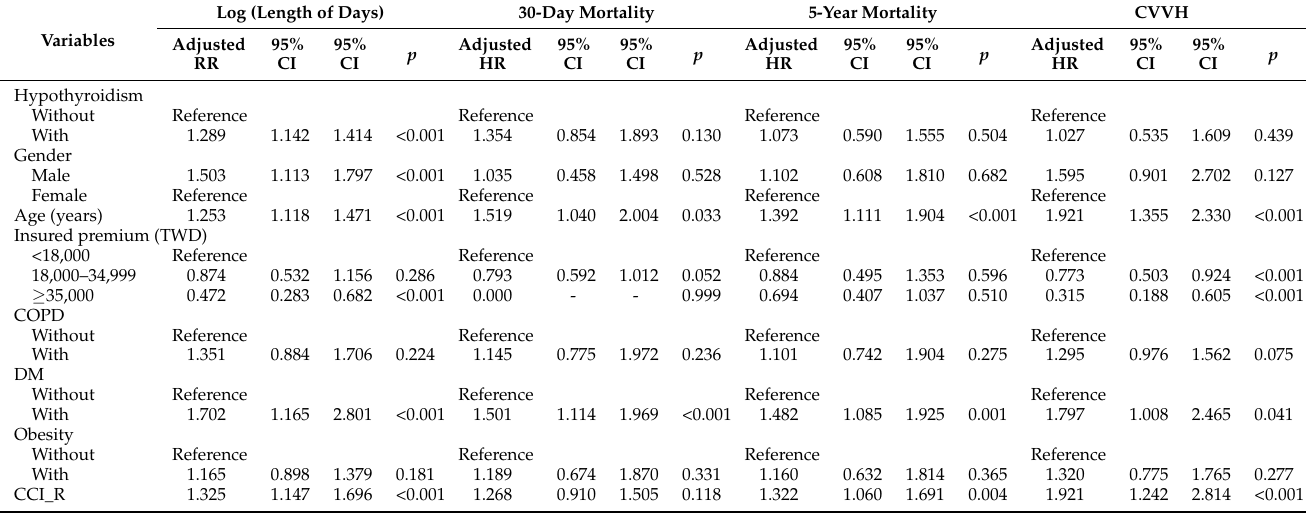
Table 3. Factors of outcomes by using linear regression and Cox regression.